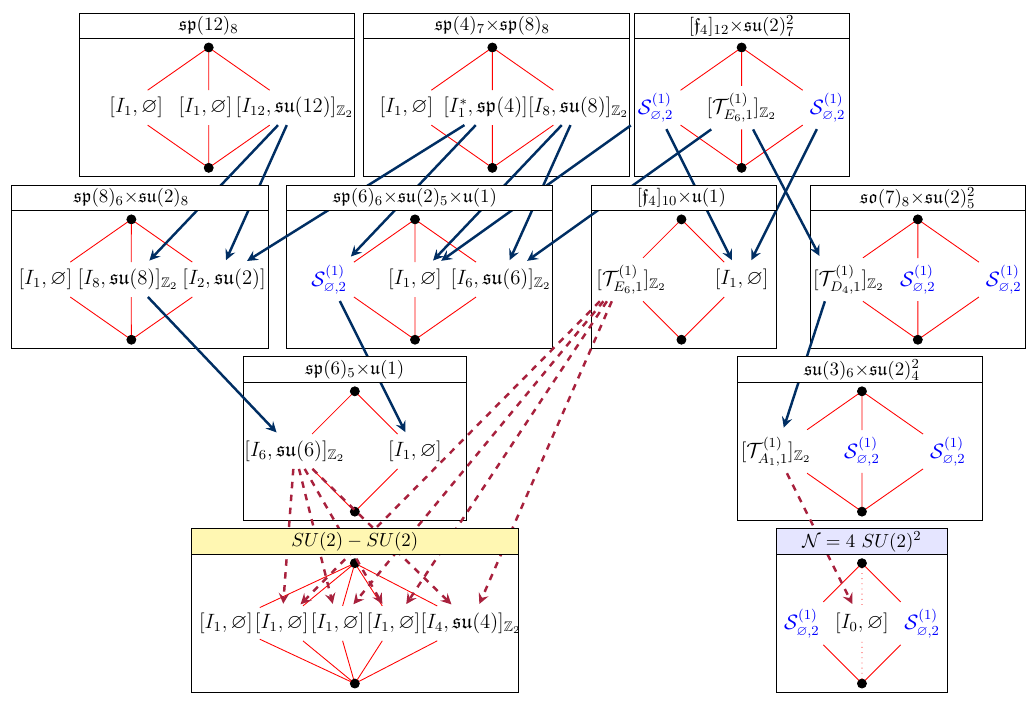
Figure 6 . Coulomb branch analysis of the mass deformations among the entries of the sp (12) − sp (8) − f 4